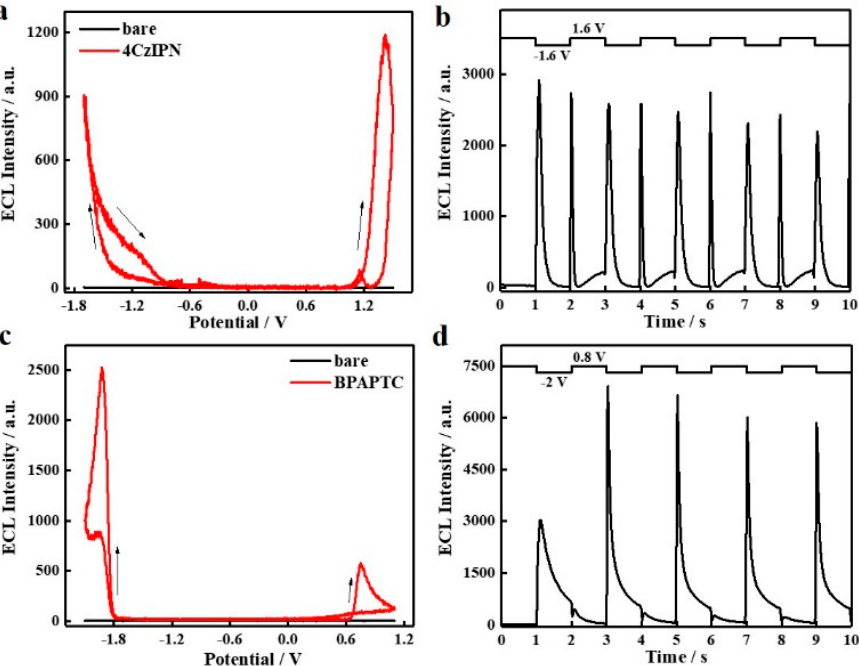
Figure 2. ECL curves ( a ) and ECL transient curves ( b ) of 0.1 mM 4CzIPN DCM solution containing 0.1 M TBAPF 6 ; ECL curves ( c ) and ECL transient curves ( d ) of 0.1 mM BPAPTC DCM solution containing 0.1 M TBAPF 6 .